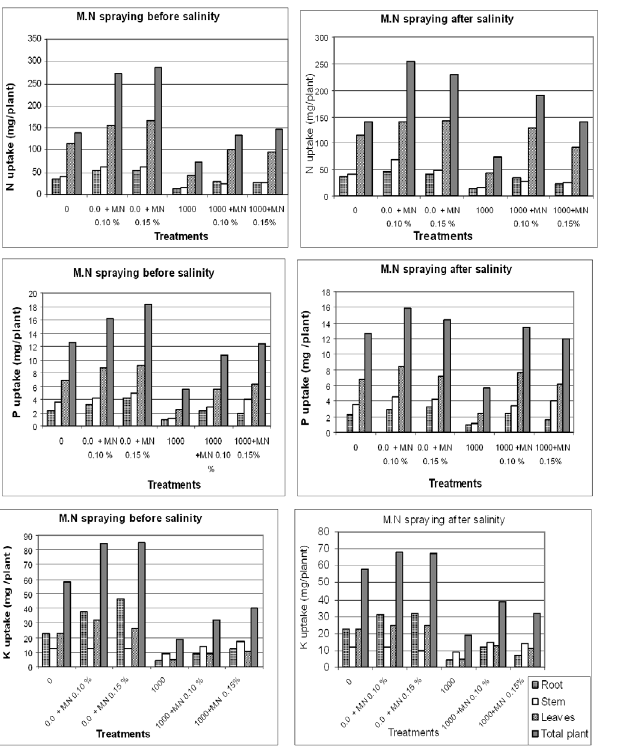
Fig. 3. Effect of micronutrients spraying before and after salinity treatments on N, P, K uptake (mg /plant) of faba bean plant; 0=without salinity; 1000=1000 ppm NaCl; M.N=micronutrient